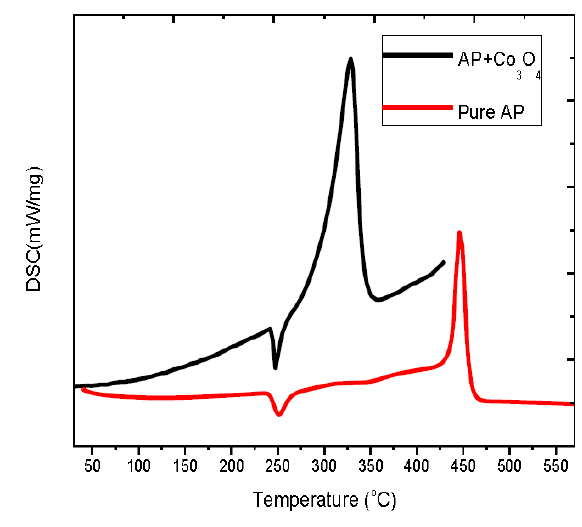
Figure 6: The corresponding DSC curves for pure AP and flake like Co O particles. 3 4